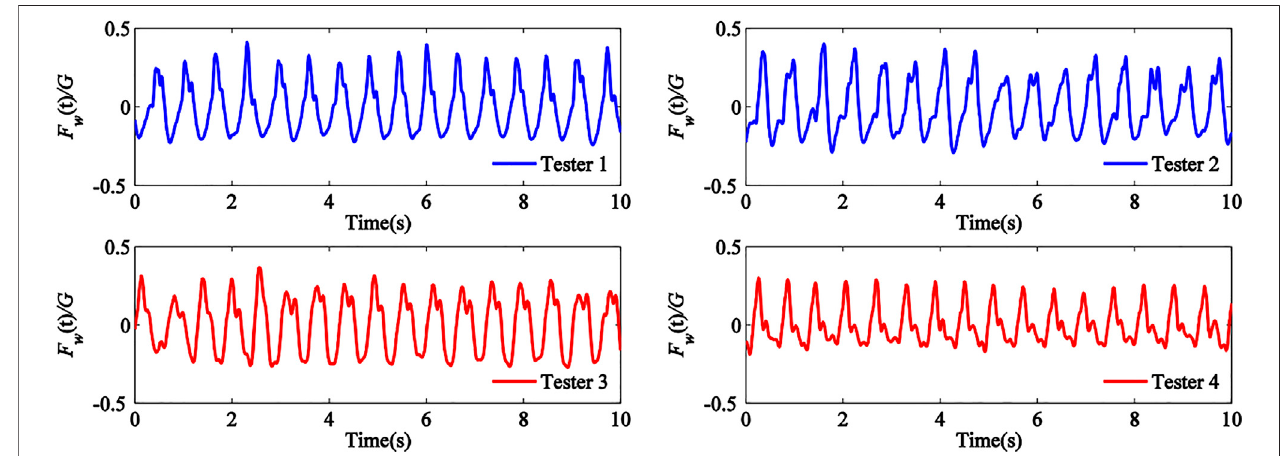
FIGURE 8 | Time histories of non-dimensional pedestrian walking loads for different testers.